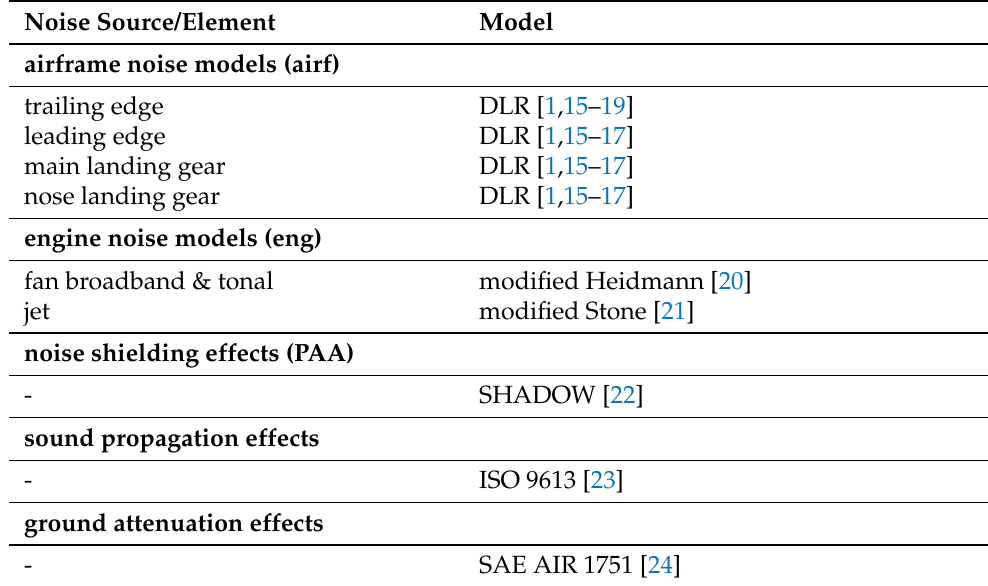
Table 1. PANAM system noise assessment: source models selected for this